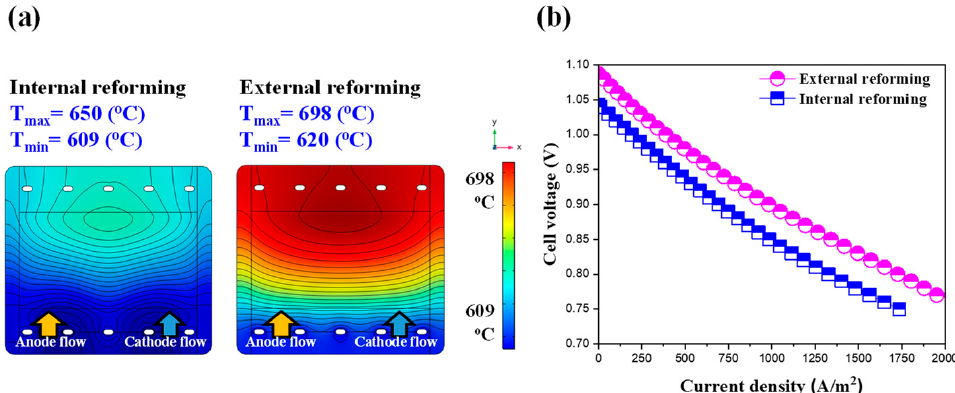
Figure 18. ( a ) Temperature distribution and ( b ) i–V curve under optimal conditions for external and internal reforming-type MCFCs.